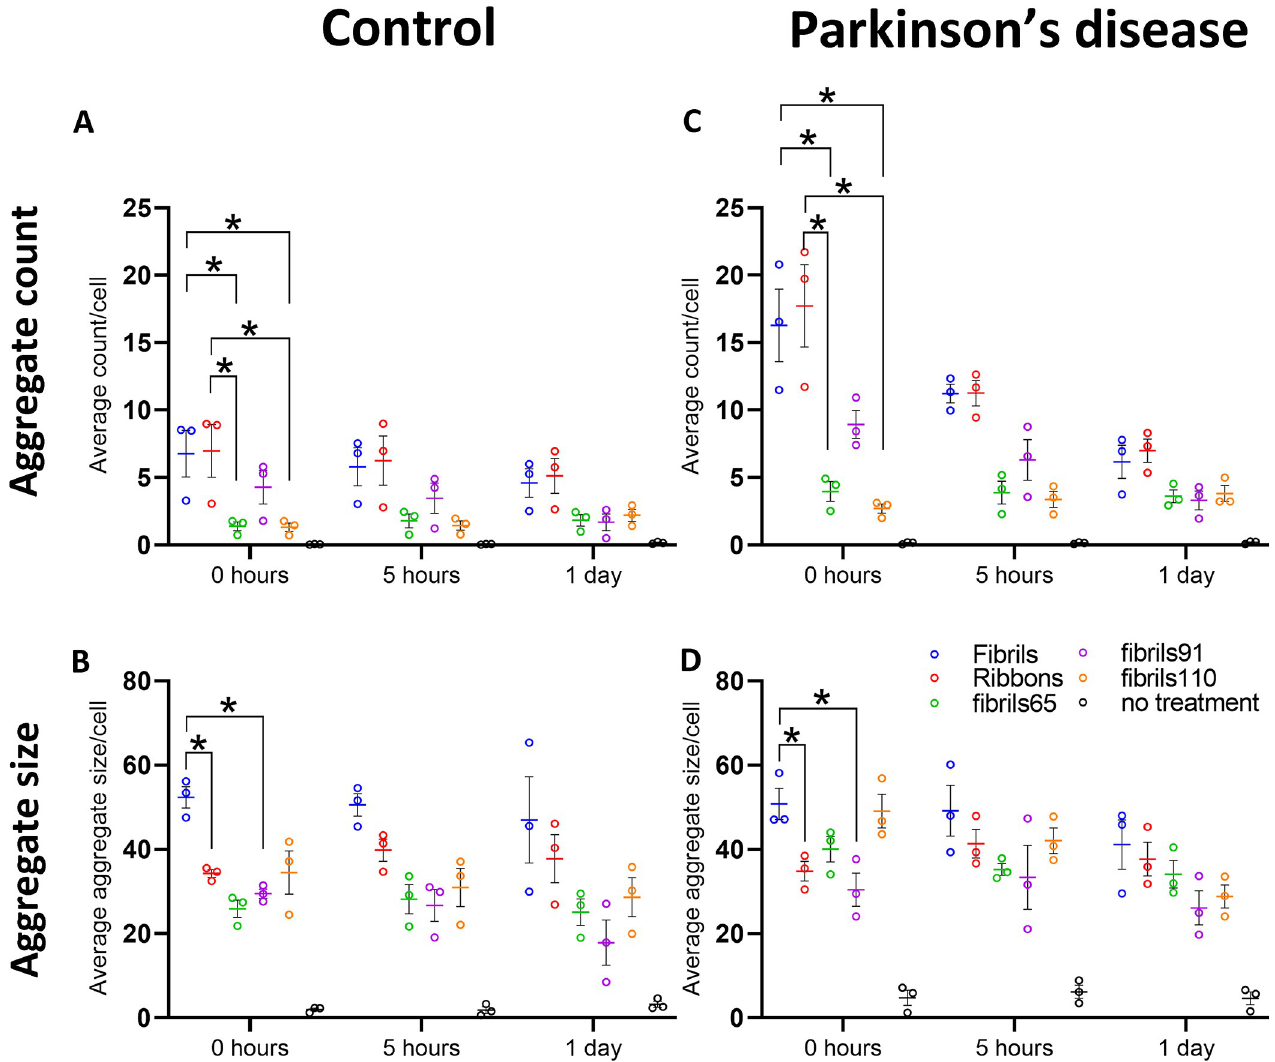
Fig 4. Strain-specific differences in control and PD-derived post-mortem pericytes. (A-B) Average aggregate count/cell analysis and (C-D) average aggregate size/cell analysis based on AA103-108 for control pericytes (n = 3) and PD pericytes (n = 3). Two-way ANOVA was used with Tukey’s post hoc adjustment for multiple comparisons. An asterisk indicates significant differences in control and PD-derived post-mortem pericytes � (p <